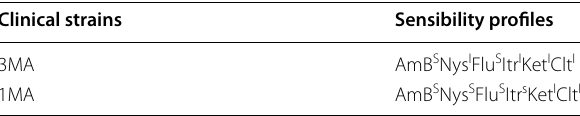
Table 1 Susceptibility profiles of the clinical strains